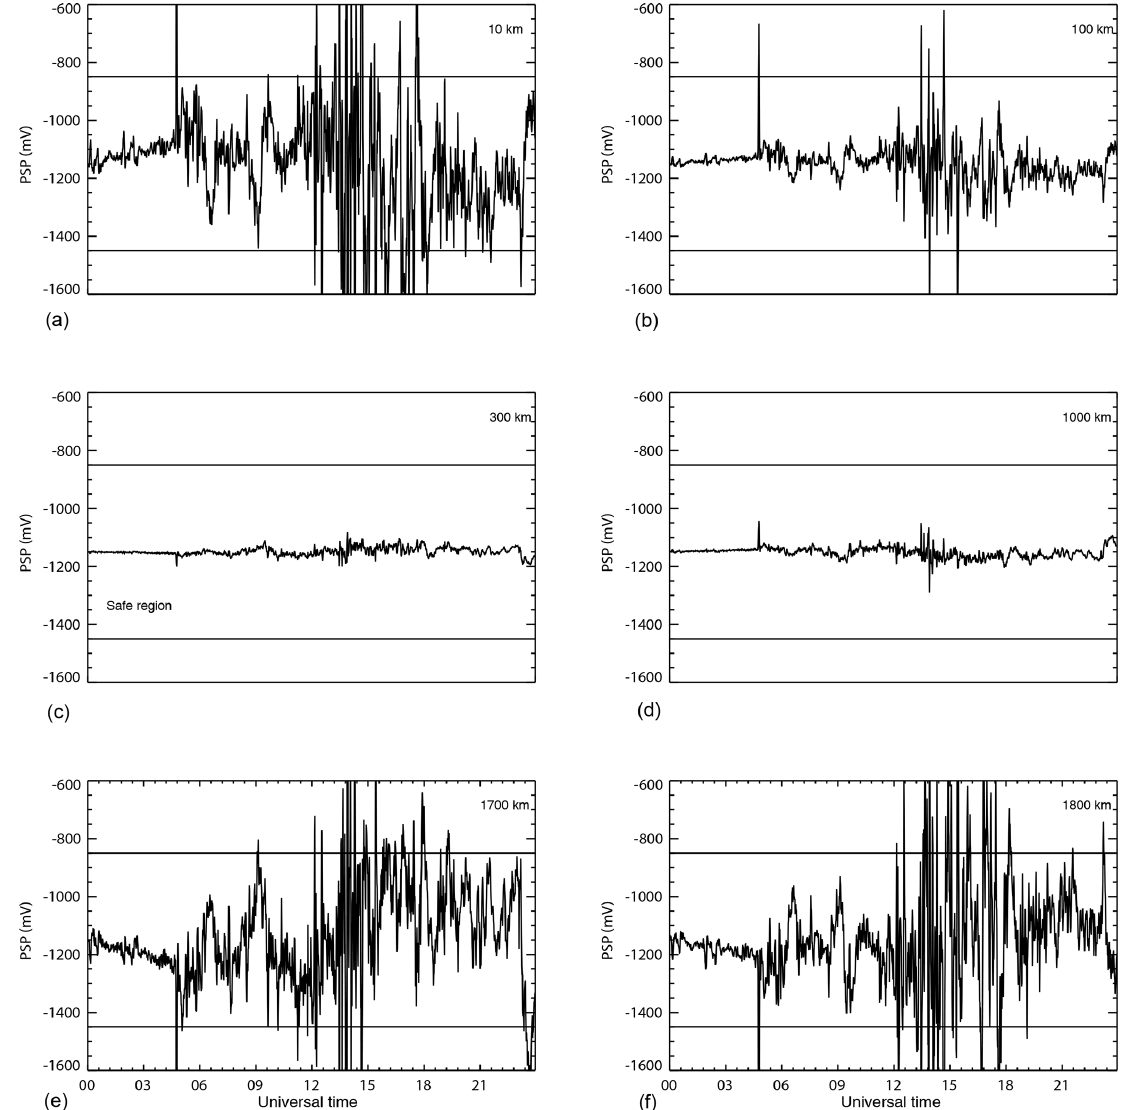
Figure 3. Pipe-to-soil potential (PSP) obtained by DSLT theory for different sites (values in km at the top right of each panel) along the GASBOL pipeline for a terminating impedance of 0.1 (cid:127) during the 17 March 2015 geomagnetic storm. Solid lines delimit the safe range of the GASBOL operation. The pipeline route has a total extension of 1814km and runs through 557km to the Brazilian